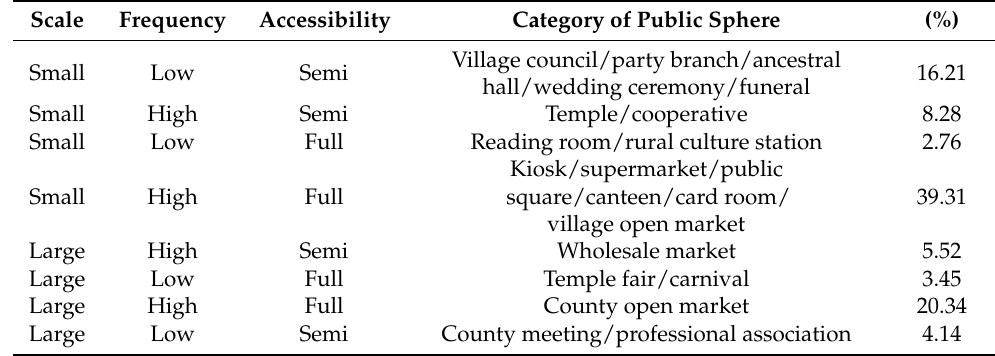
Table 1. Types and proportion of rural public